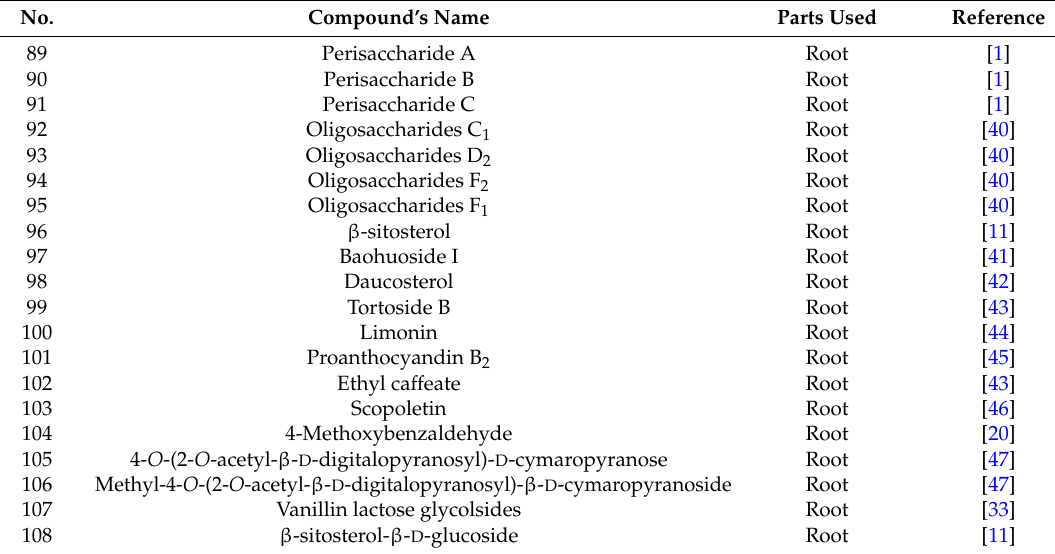
Table 5. Others components from Cortex Periplocae